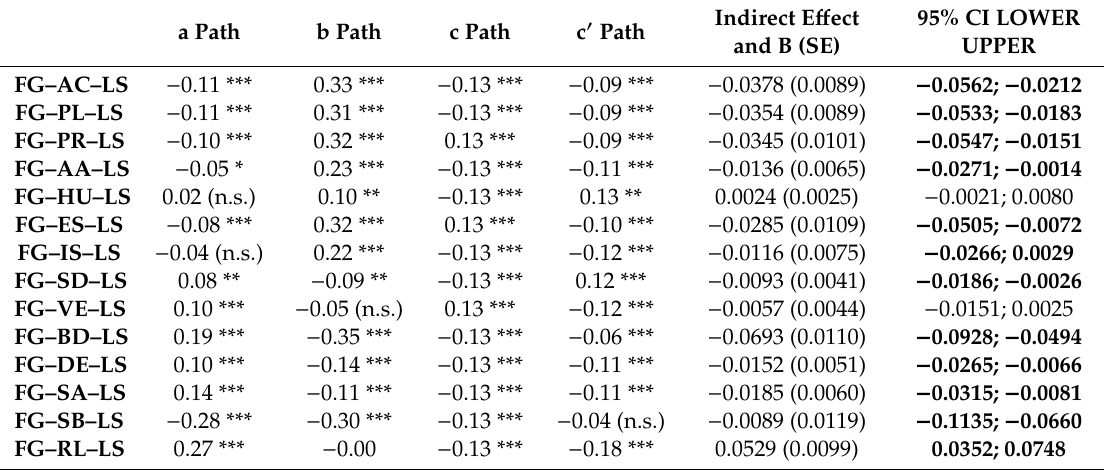
Table 4. The role of coping strategies on fear / guilt and life satisfaction (N =